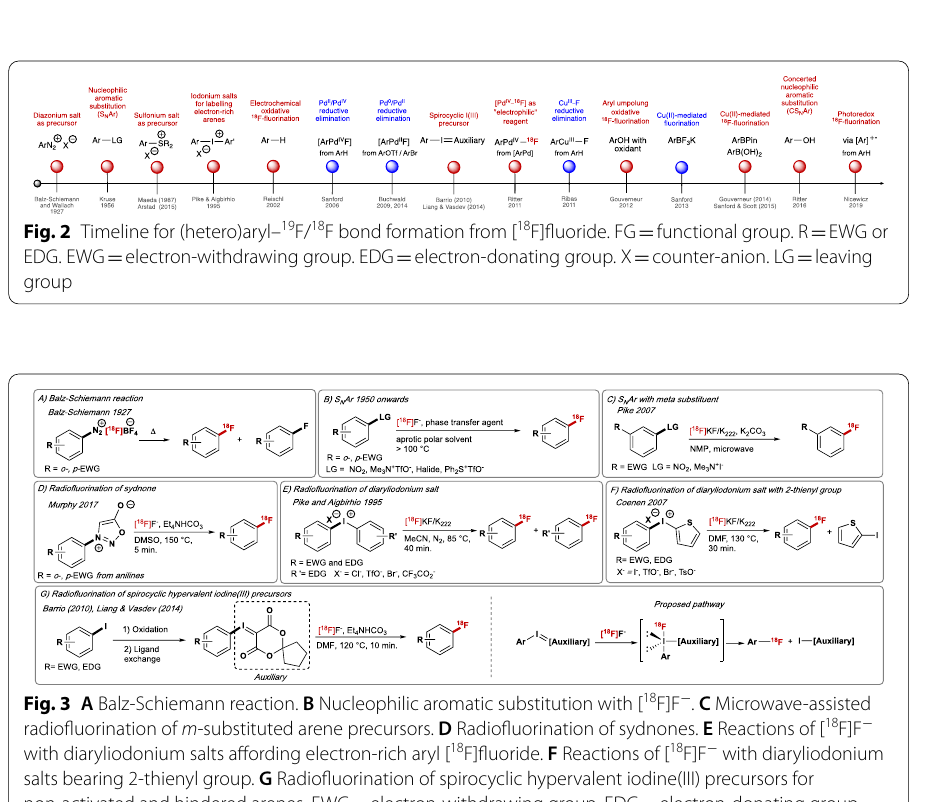
Fig. 3 A Balz-Schiemann reaction. B Nucleophilic aromatic substitution with [ 18 F]F − . C Microwave-assisted radiofluorination of m -substituted arene precursors. D Radiofluorination of sydnones. E Reactions of [ 18 F]F − with diaryliodonium salts affording electron-rich aryl [ 18 F]fluoride. F Reactions of [ 18 F]F − with diaryliodonium salts bearing 2-thienyl group. G Radiofluorination of spirocyclic hypervalent iodine(III) precursors for non-activated and hindered arenes. EWG electron-withdrawing group. EDG electron-donating group. = =